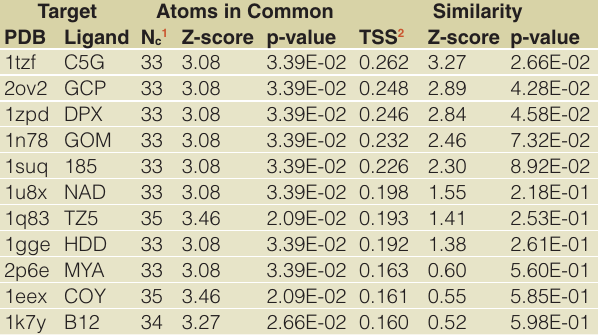
Table 3. IsoCleft Finder results for 2re9 sorted in decreasing order of Tanimoto Score of Similarity. Target Atoms in Common Similarity